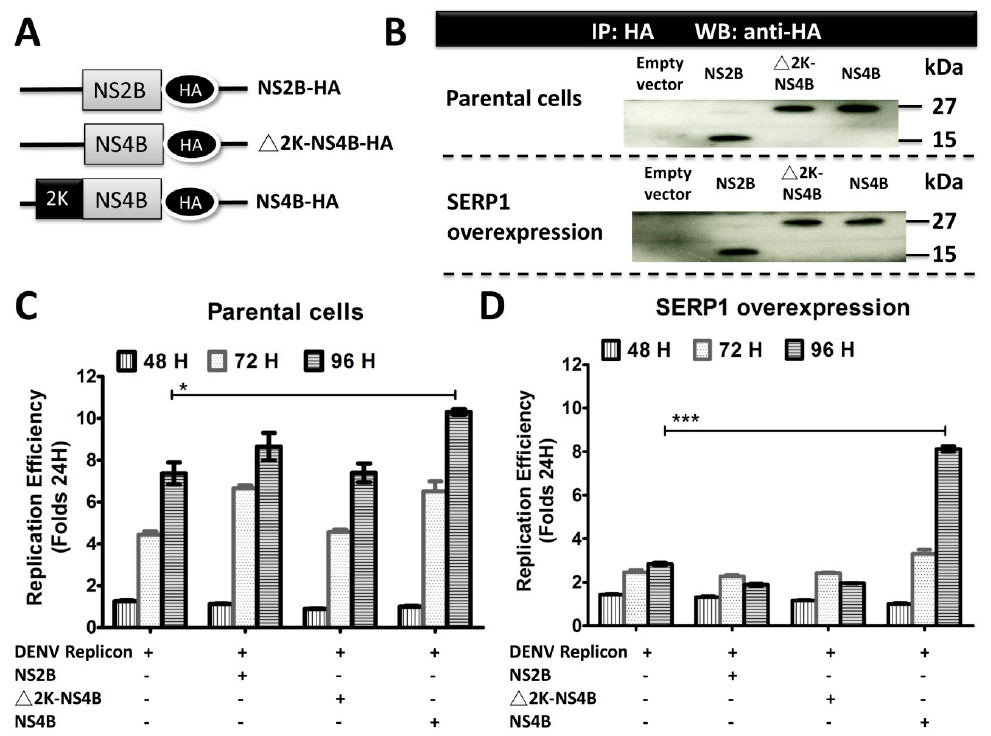
Figure 6. Overexpression of NS4B improves the virus replication in the Huh7.5 cells overexpressing SERP1. ( A ) Schematic diagram of HA C-terminal fusion constructs of NS2B and NS4B. The N-terminal 2K signal peptide was deleted ( △ 2K-NS4B-HA ) . ( B ) Immunoblot analysis of HA-tagged NS2B and NS4B proteins in the parental cells and SERP1-overexpressing Huh7.5 cells. All of the fragments